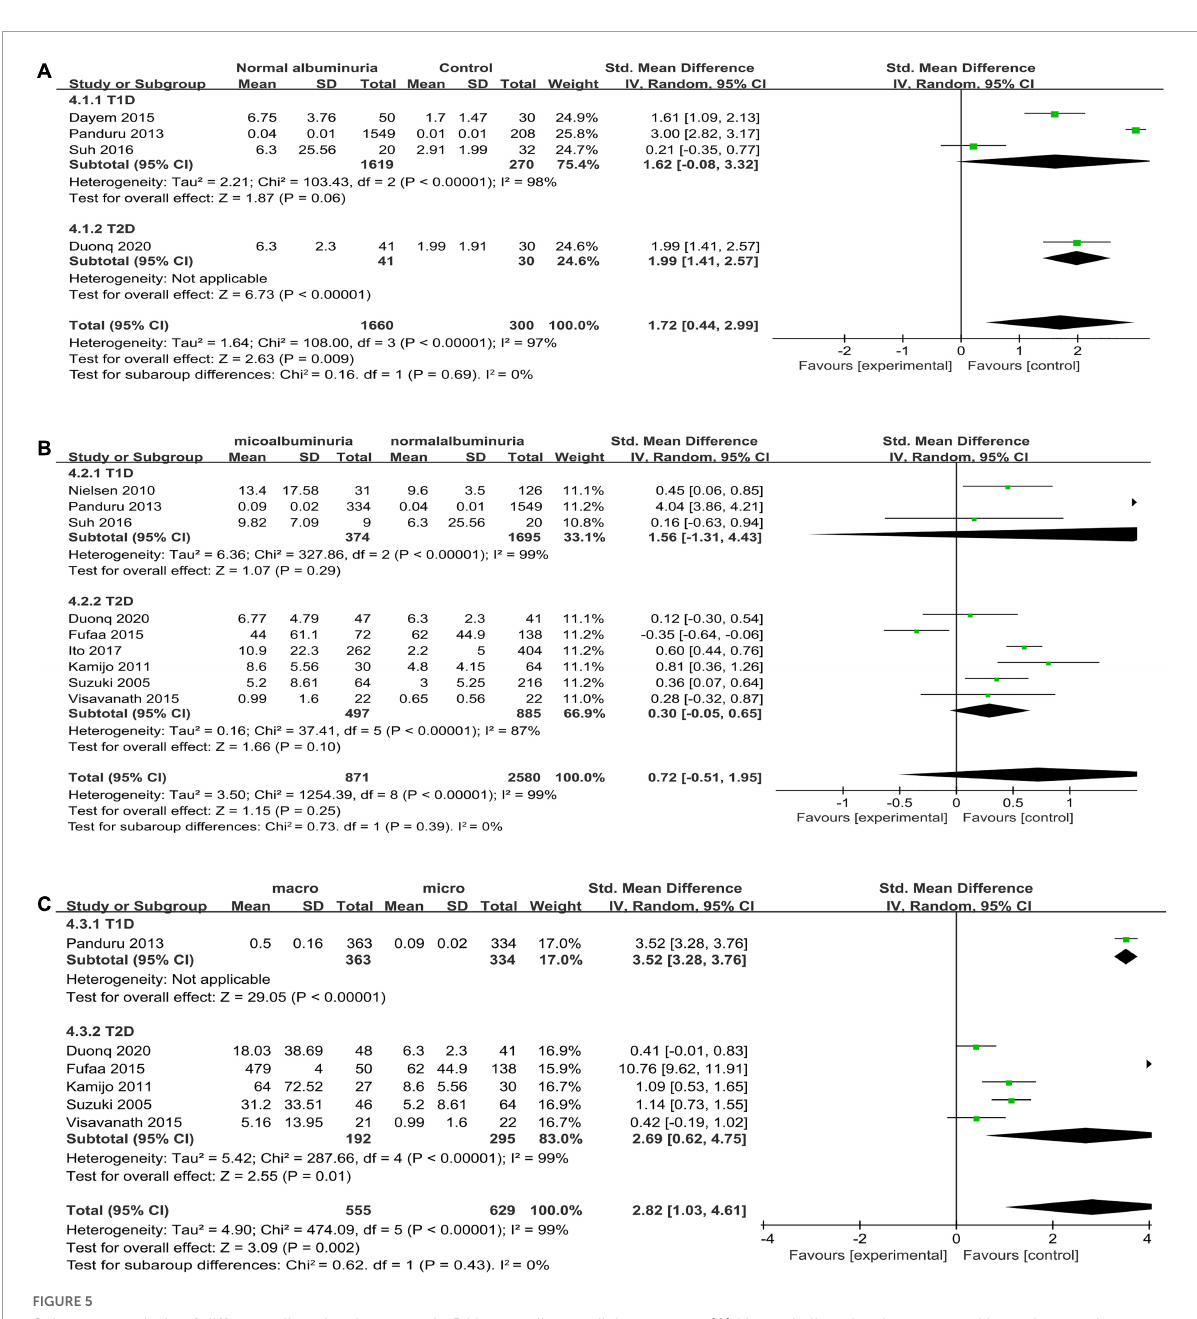
FIGURE5 Subgroup analysis of different albuminuria groups in DM according to diabetes types (A) Normal albuminuria group vs. Normal control group; (B) Miro albuminuria group vs. Normal albuminuria group; (C) Macro albuminuria group vs. Micro albuminuria